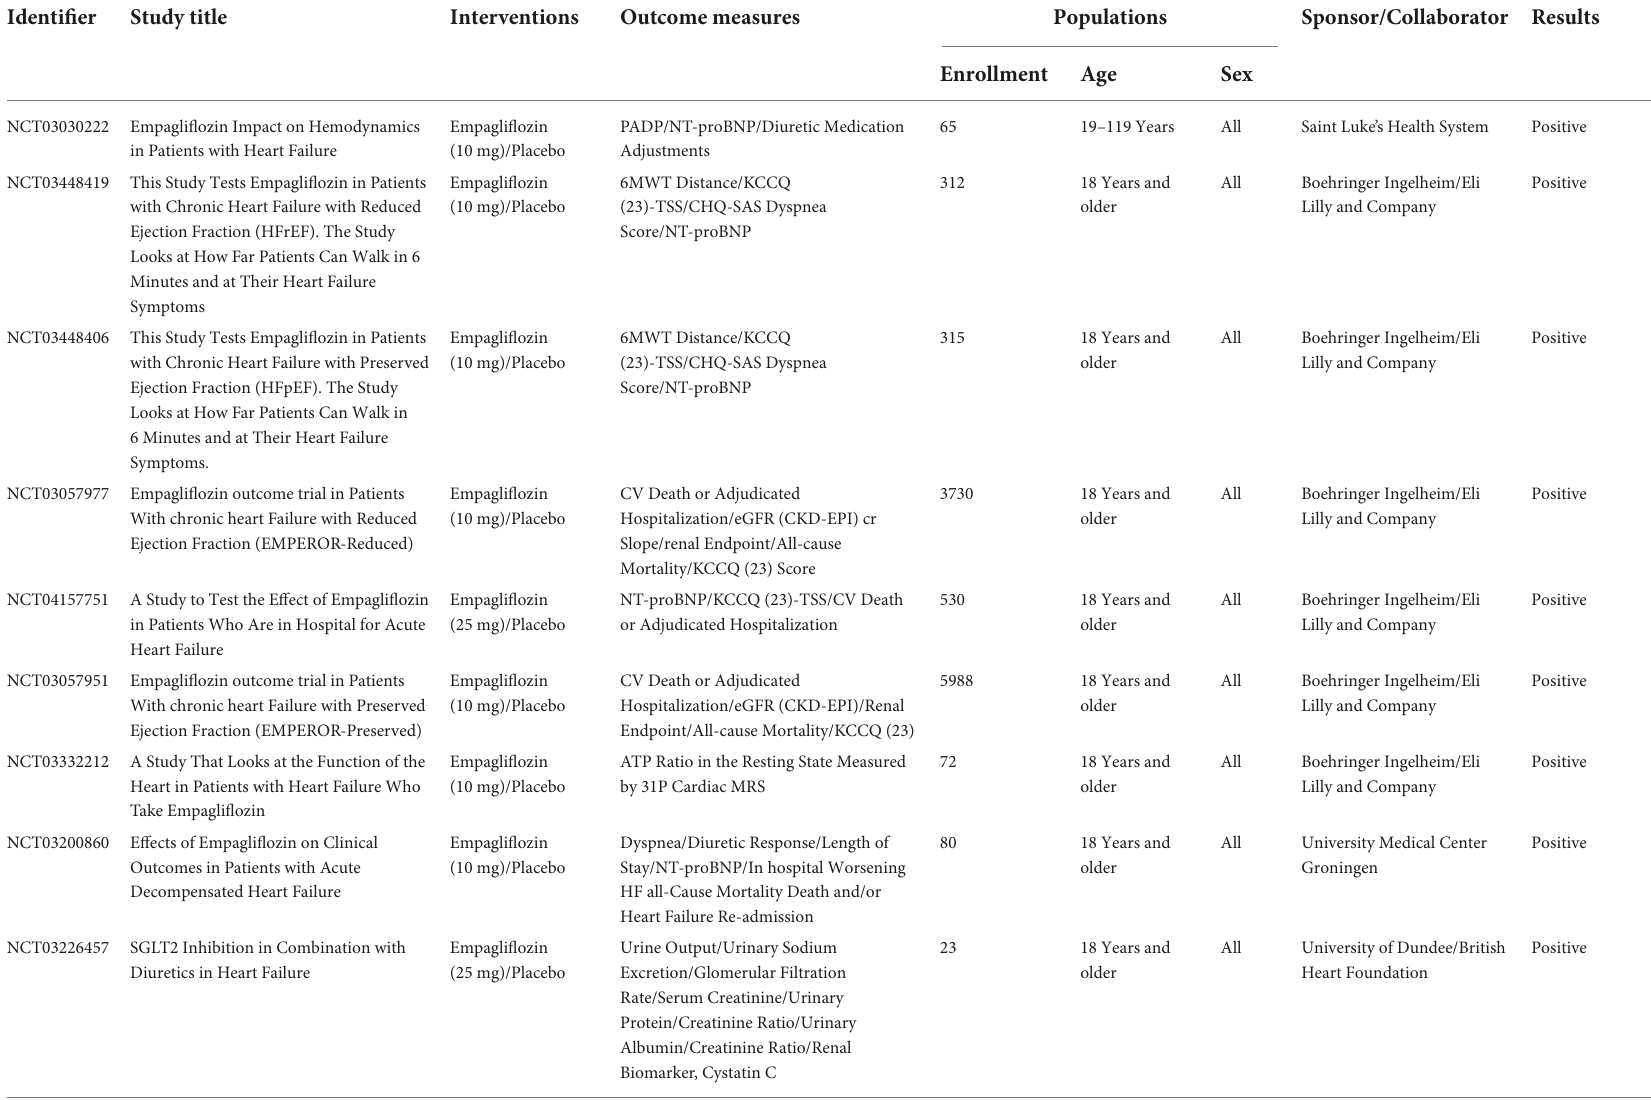
TABLE 1 Completed clinical trials of EMPA in